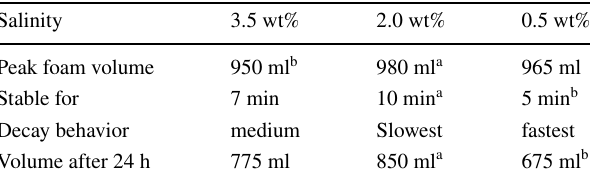
Table 6 Summary of bulk foam stability test result observations for the effect of salinity